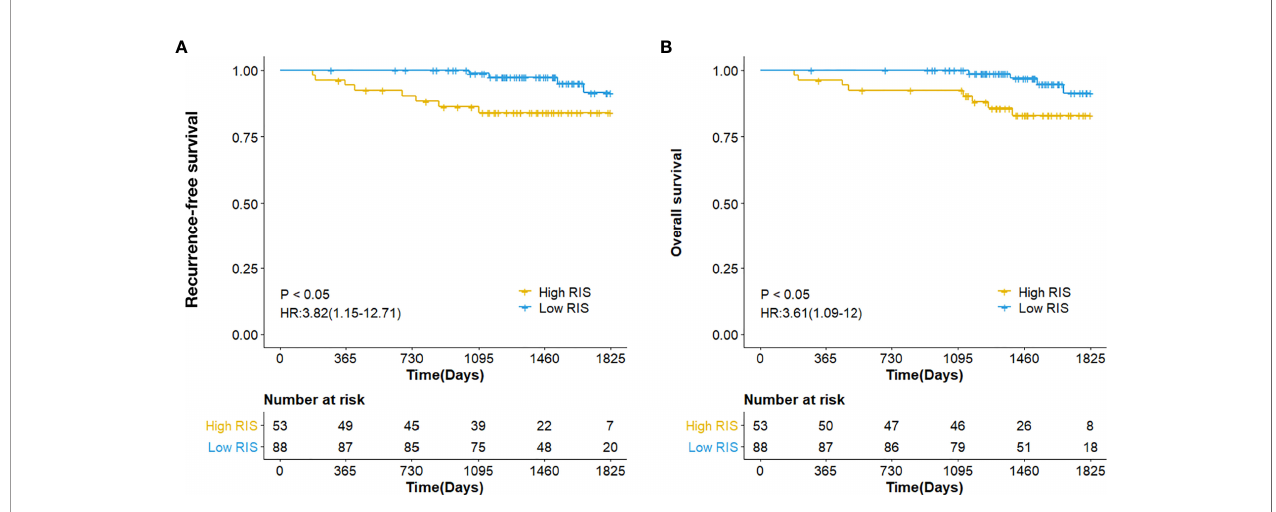
FIGURE 4 | Kaplan-Meier analysis for RFS (A) as well as OS (B) , depending upon the RIS dichotomous signature of the breast cancer